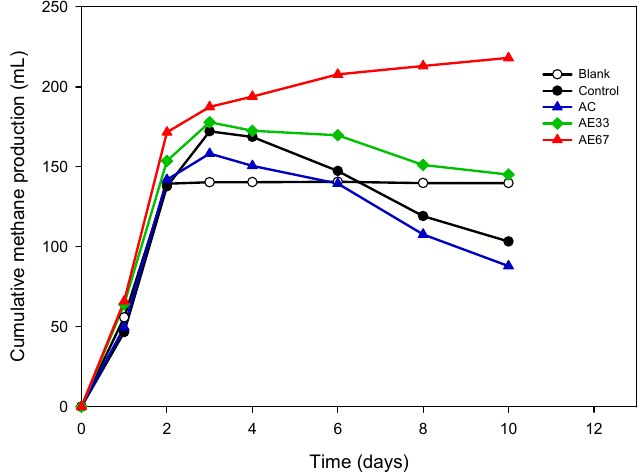
Figure 2. Cumulative methane production from coal in the anaerobic batch reactor.